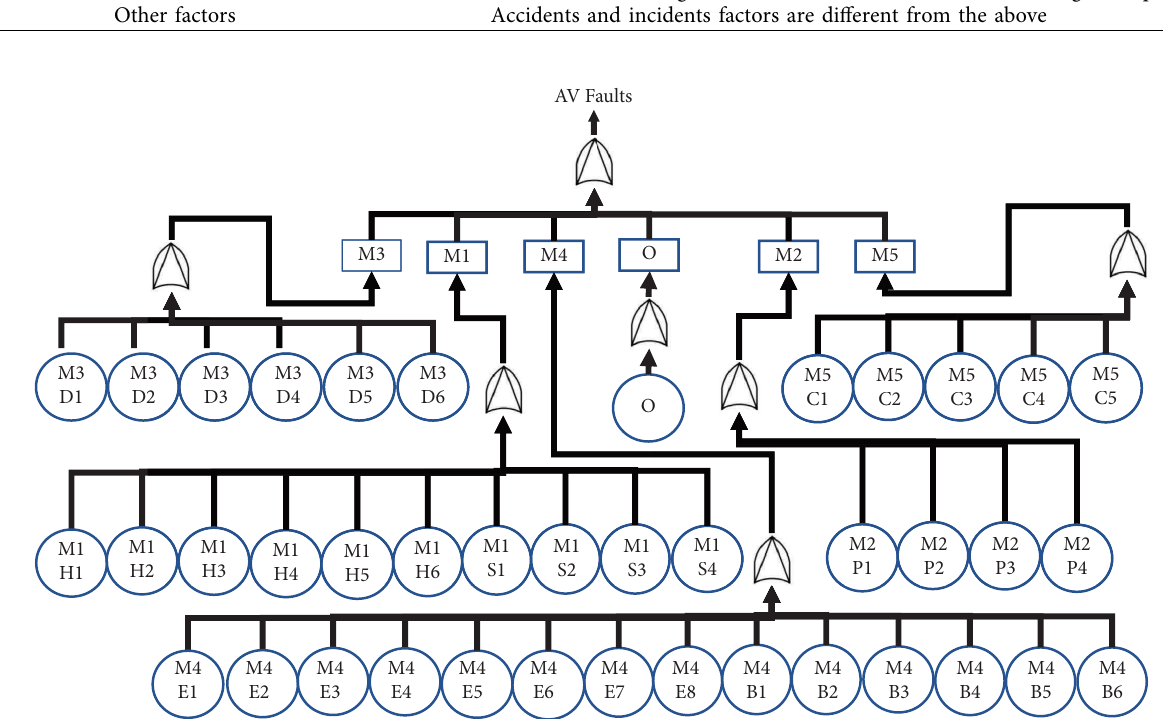
Figure 3: Relationship diagram for ADS accident groups and risk factors of software